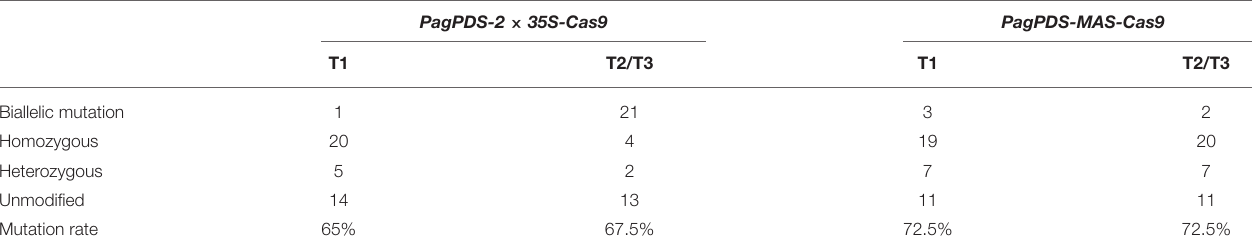
TABLE 2 | Summary of the mutation types at each target